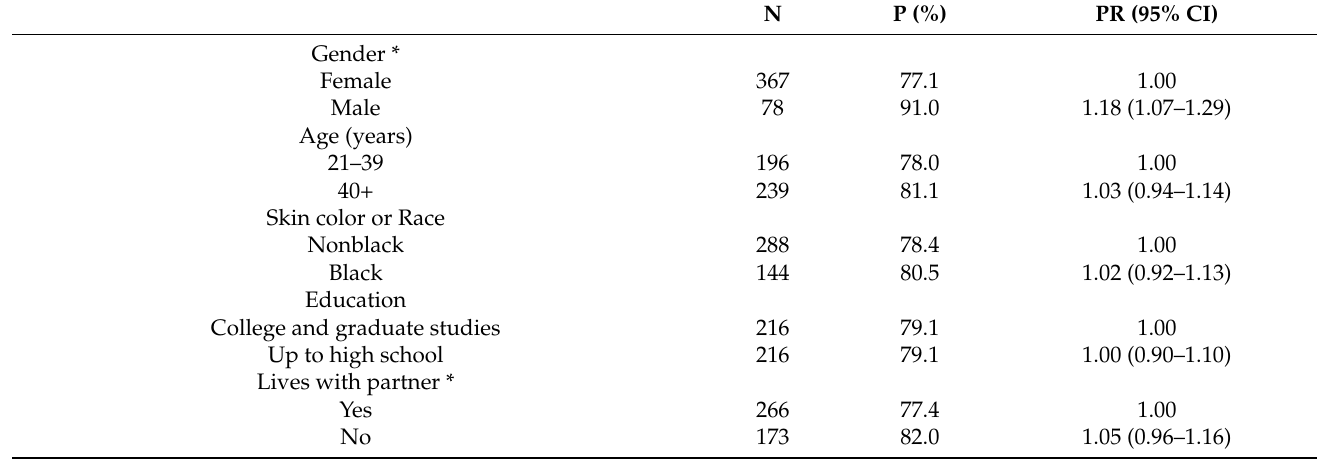
Table 4. Association between sociodemographic characteristics, occupational characteristics, vaccination- related beliefs, and vaccine hesitancy in health workers in Bahia, Brazil, in 2020. N P